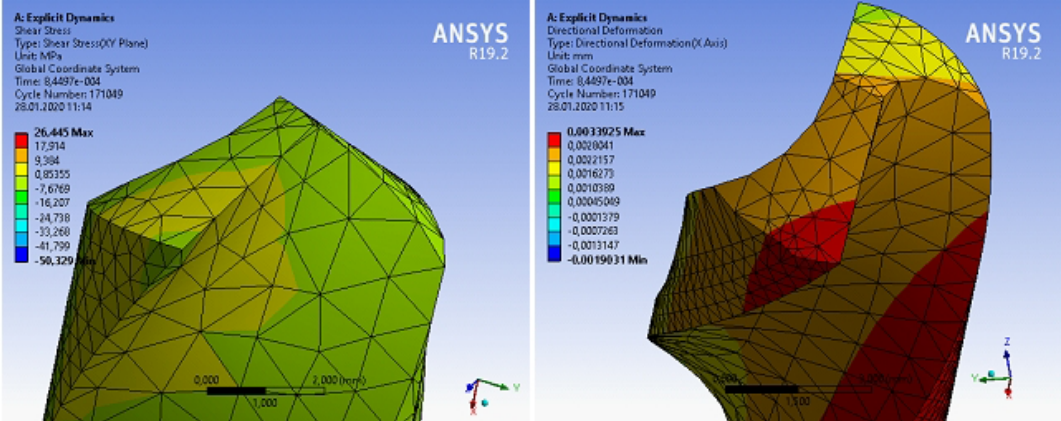
Figure 33. Ansys shear stress distribution and x -axis directional deformation.